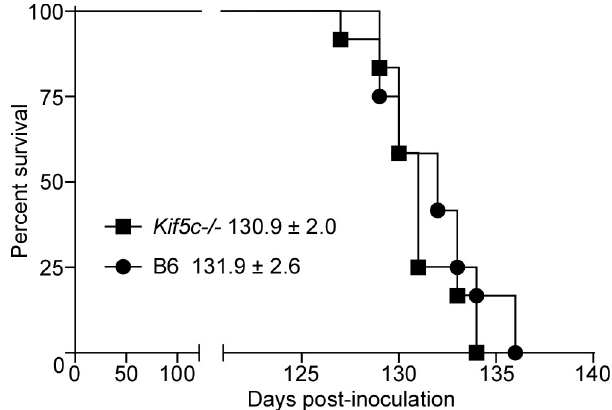
Figure 6. Survival curve of B6 and Kif5c − / − mice following 22 L scrapie infection. Twelve mice of each strain were inoculated stereotactically in the striatum with 0.5 µL of 10% 22 L scrapie brain homogenate. Mice were euthanized when advanced signs of terminal disease were present. Black squares indicate Kif5c − / − mice, black circles indicate B6 mice. The mean ± standard deviation (SD) for each strain are shown adjacent to the legend. Statistical analysis of the survival curve using the Log-rank (Mantel–Cox) test indicated no difference ( p = 0.3152).